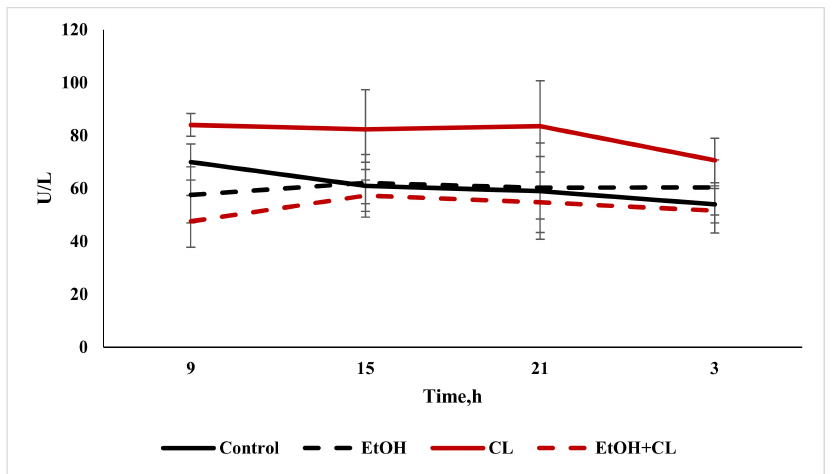
Figure 11. Daily fluctuations in the activity of ALT in the blood plasma of